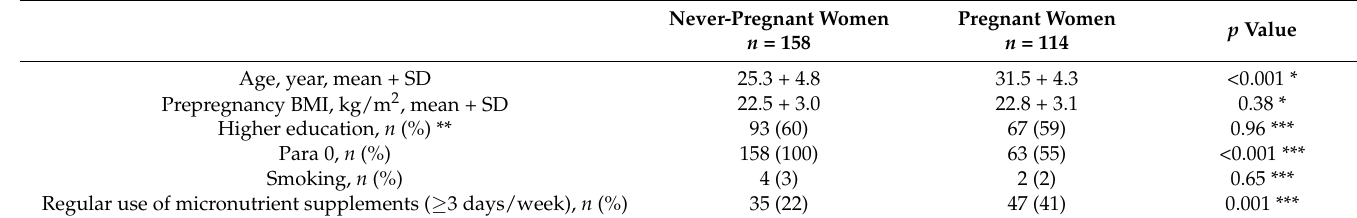
Table 1. Baseline characteristics of never-pregnant and pregnant women in pregnancy week 18. BMI = body mass index.